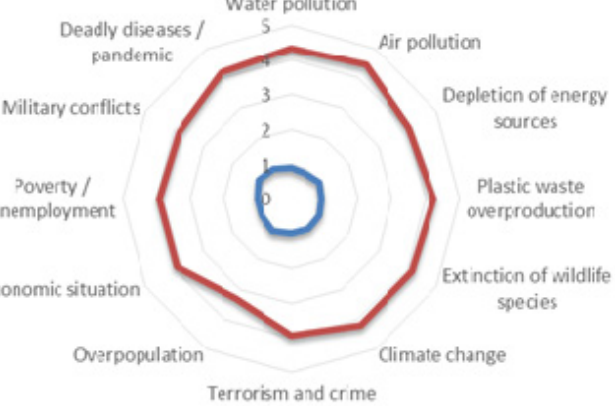
Figure 4. The importance of global threats.